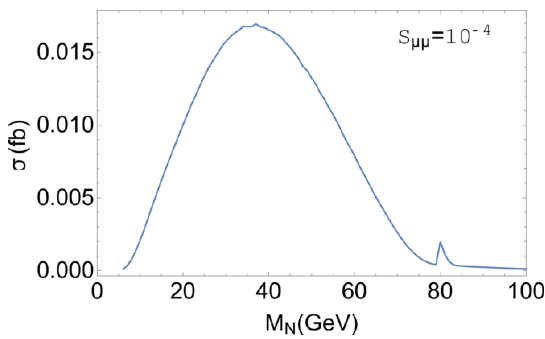
Figure 6 . Total cross section for the process e + e (cid:0) ! N(cid:22) (cid:6) W (cid:7) ! (cid:22) (cid:6) (cid:22) (cid:6) + 4 j after all the cuts in eqs. (3.4){(3.5) and eqs. (3.8){(3.9) at the CEPC, with S (cid:22)(cid:22) = 10 (cid:0) 4 .